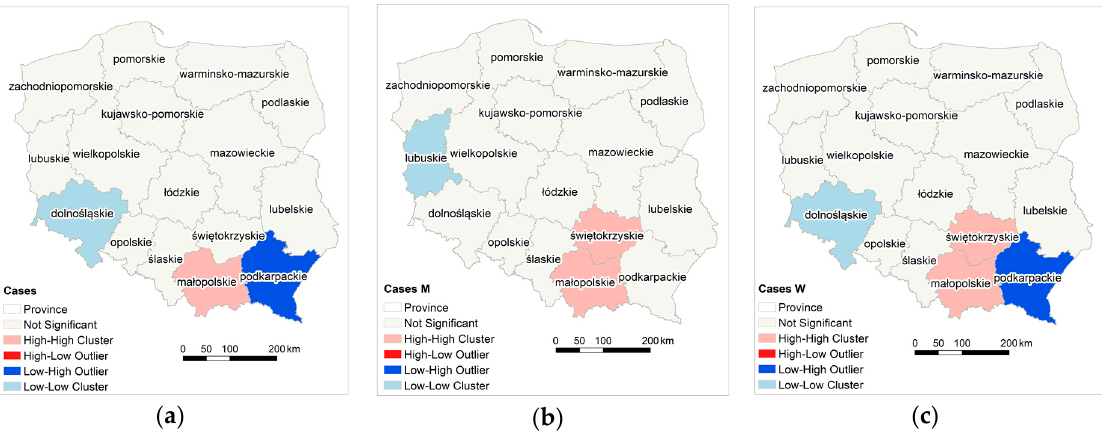
Figure 6. Local autocorrelation of MM morbidity rate in provinces; ( a ) cases all; ( b ) cases M; ( c ) cases W.